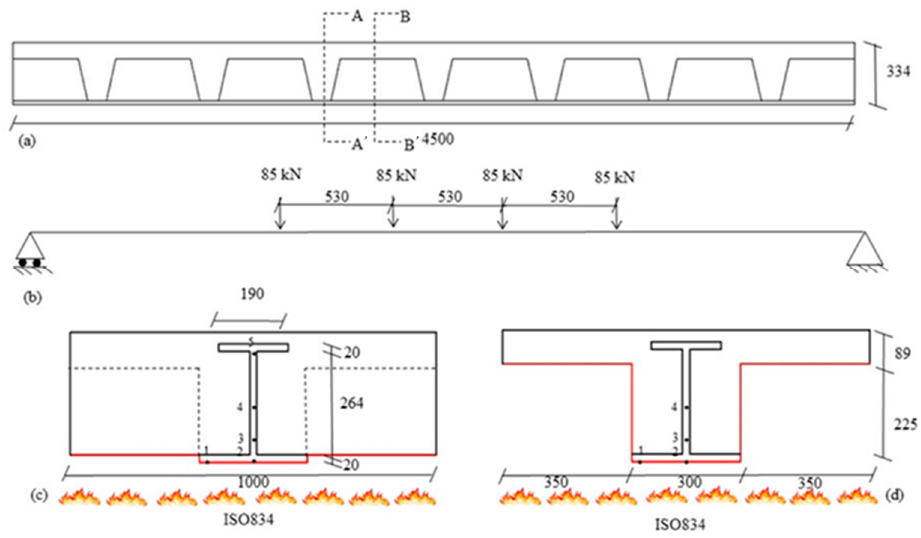
Figure 2. The Tested Specimen WFRC 67756, ( a ) Elevation; ( b ): Loading conditions; ( c ) Section at AA’; ( d ) Section at BB’ .